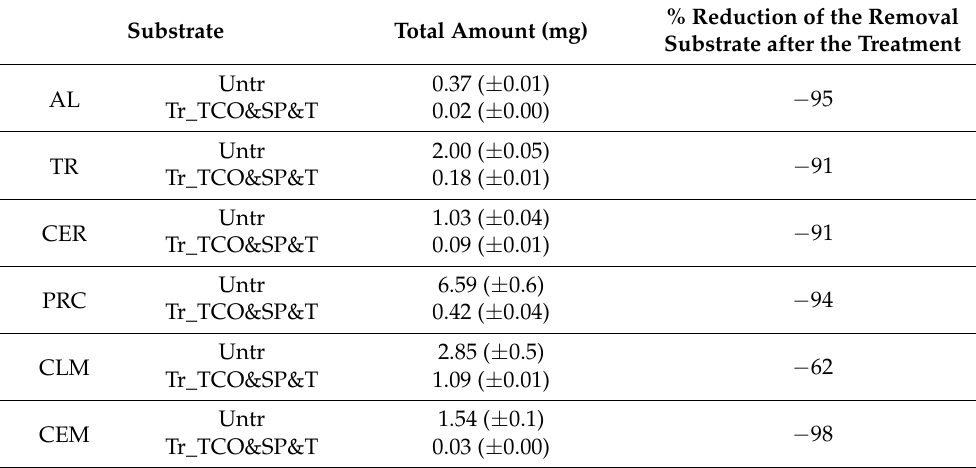
Table 5. Results obtained through the performance of peeling